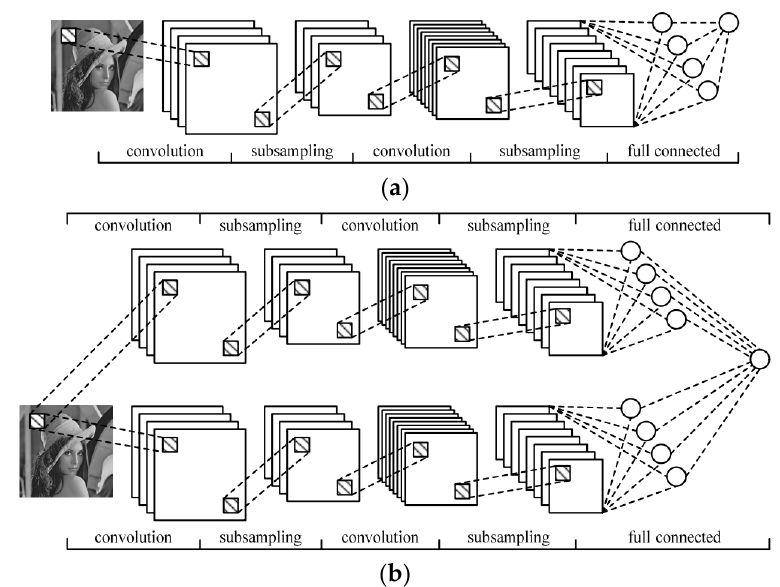
Figure 1. Structure of convolutional neural networks (CNNs): ( a ) structure of a single-channel CNN; ( b ) structure of a multi-channel CNN.